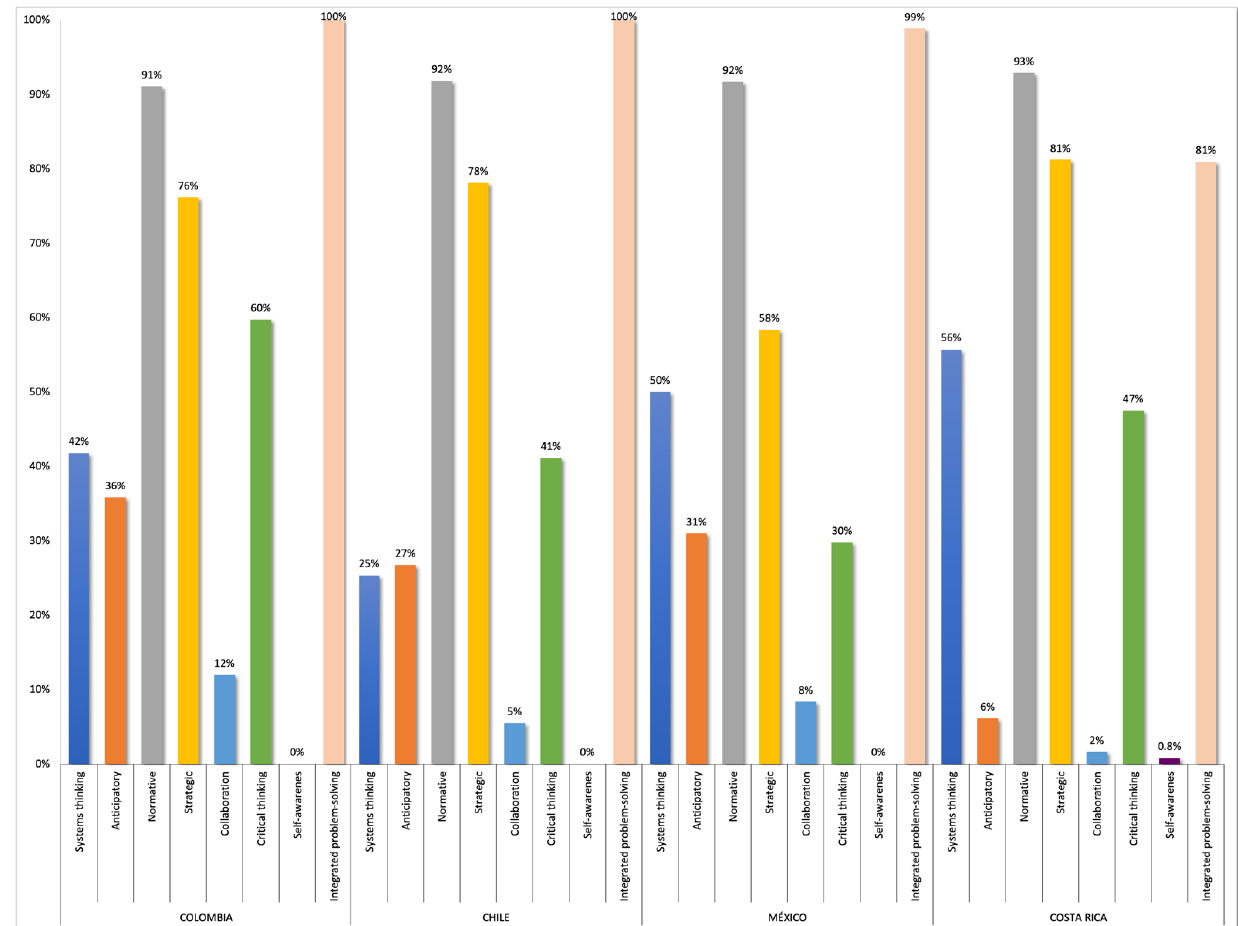
Figure 1. Competence distribution for sustainability by country.